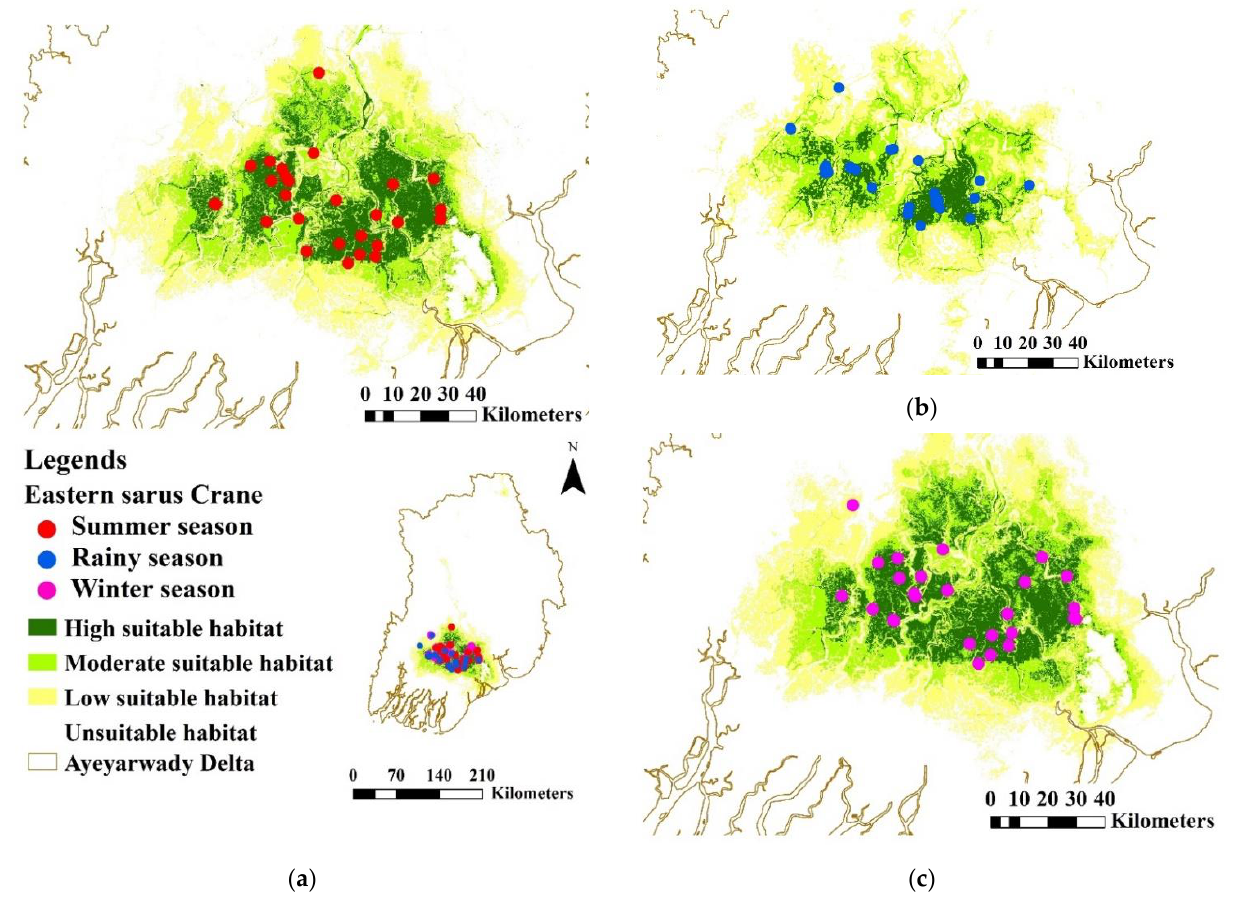
Figure 4. Locations of eastern sarus crane ( Antigone antigone sharpii ) in Ayeyarwady Delta, the Union of Myanmar in ( a ) the summer season, ( b ) the rainy season, and the winter season ( c ). Table 1. Suitable habitat analysis for the summer season, the rainy season, and the winter season by using MaxEnt and population home ranges by using the Minimum Convex Polygon (95 % MCP) and the Kernel Density Estimate (95% KDE) for eastern sarus cranes ( Antigone antigone sharpii ) in Ayeyarwady Delta, the Union of